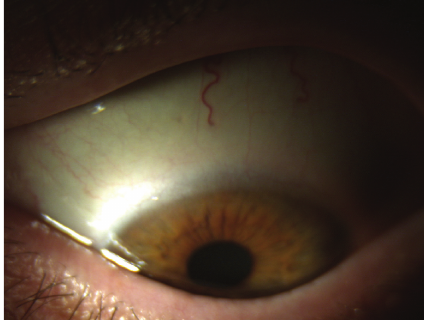
Figure 8: Left eye before